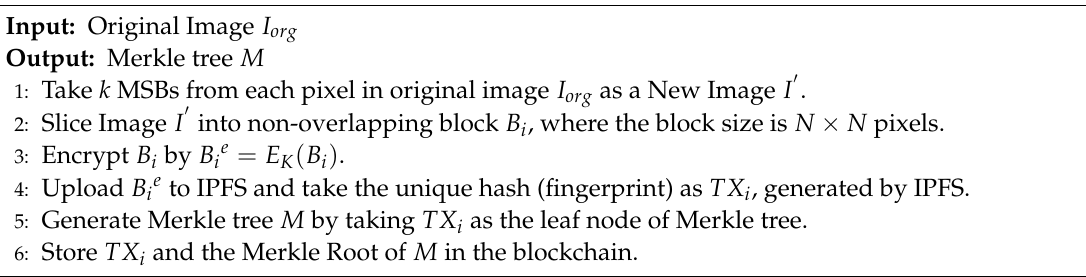
Procedure 1 Merkle Tree Generation